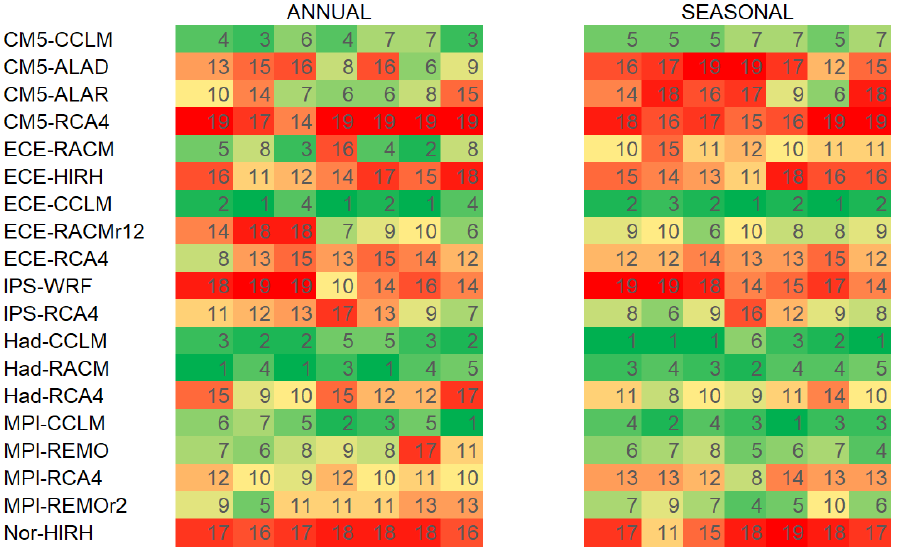
Figure 16. Overall